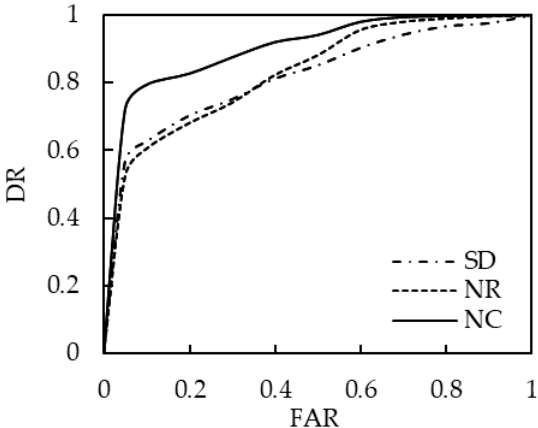
Figure 6. ROC comparison of the three difference images under detection rate (DR) and false alarm rate (FAR) indices by using the OTSU thresholding segmentation method.